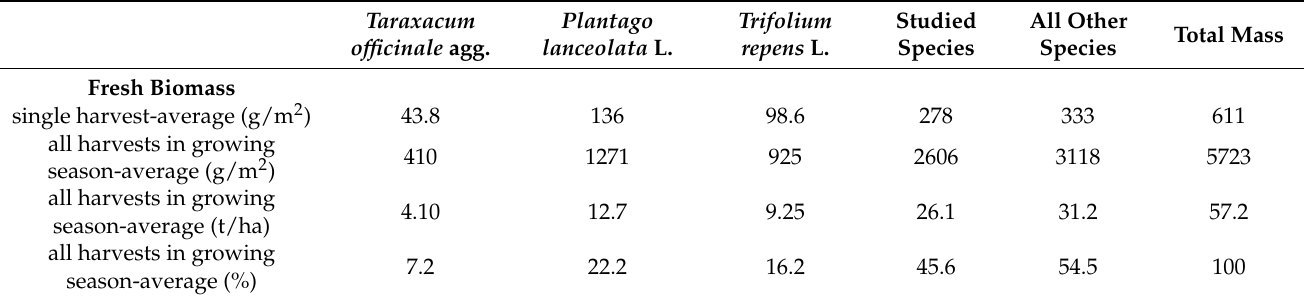
Table 4. Average values of fresh and dry biomass of plant species collected from 16 sites from the Varaždin area, heavy metal removal and cleanup